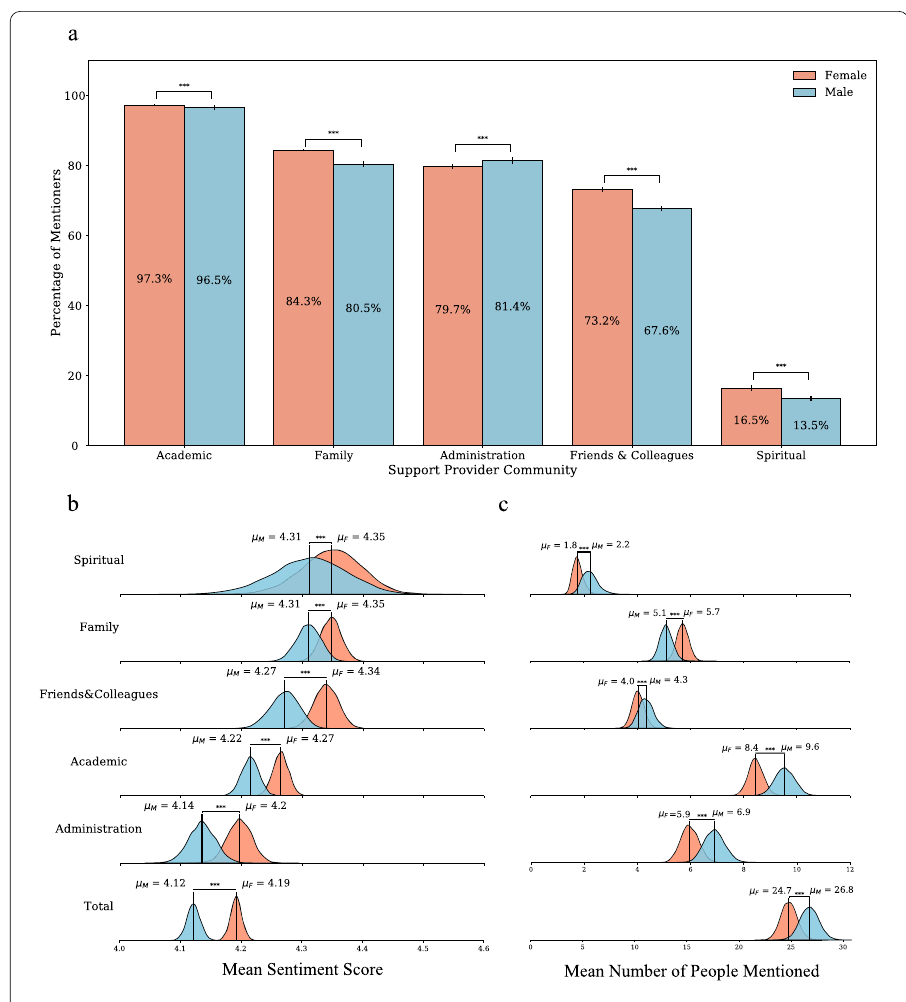
Figure 2 Gender differences in support provider communities. Percentage of students referring to different categories of support providers varies across genders ( a ). Sentiment scores differ when mentioning the support providers ( b ). Mean number of people mentioned alter across genders for different support provider categories ( c ). Individual groups were compared using the two-sided t-test. ***, p ≤ 0.001; **, p ≤ 0.01; *, p ≤